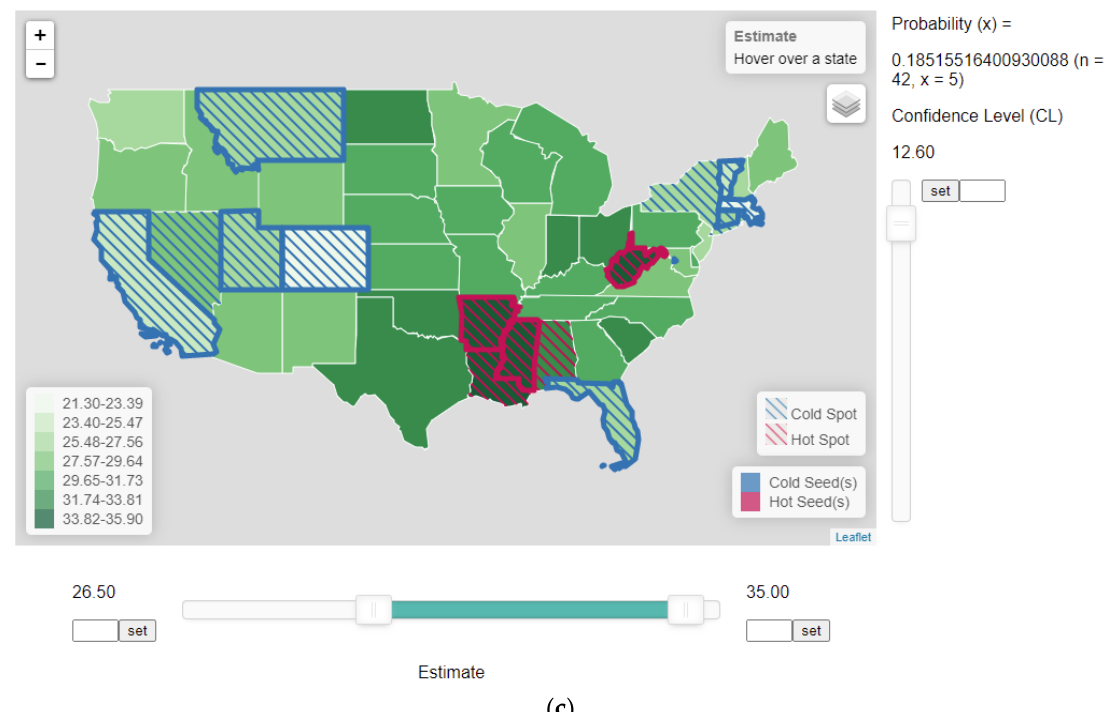
Figure 5. The web-based application implementing the naïve HSCS identification method using the 2014 obesity data with 26.5 and 35 as the lower and upper threshold values, respectively, in the horizontal slider in the bottom. ( a ) Confidence level is set to 0.95, corresponding to an alpha of 0.05 such that all estimates in states adjacent to the seeds are significantly different. Only those states beyond the threshold values of 26.5 (lower) and 35 (upper) are treated as HSCS. ( b ) Confidence level is lowered to approximately 50% to include Louisiana as part of the hot spot, and New York as part of the cold spot. ( c ) Confidence level is further lowered to about 12.6% to include Nevada as part of the cold spot, and Alabama becomes part of the hot spot. The number of comparisons ( n ) and the number of neighboring states to be added to the clusters ( x ) are reported in the application.